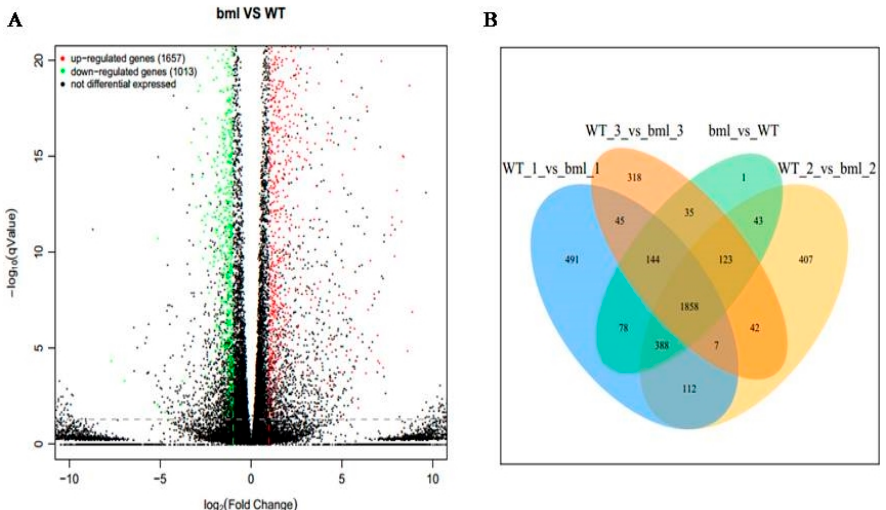
Figure 3. Volcano map and Venn diagram of DEGs. ( A ) . DEGs are shown by volcano map between bml and WT at early-tillering stage. The horizontal axis is the fold-change (log 2 (B/A)) value of the differential expression of the gene in different groups of samples, and the vertical axis is the statistical significance level with p value representing the changes in gene expression. Each point in the figure represents a gene, in which red indicates up-regulated genes, green indicates down-regulated genes, and black indicates non-differentiated genes. ( B ) . DEGs between bml mutant and WT at early-tillering stage are plotted by Venn diagram. The comparison between different groups is represented by different colors, and the numbers in the figure represent the number of specific or shared DEGs. The overlap region indicates the number of differentially expressed genes shared by different comparison groups, and the non-overlapping region indicates the number of DEGs unique between the different comparison groups.